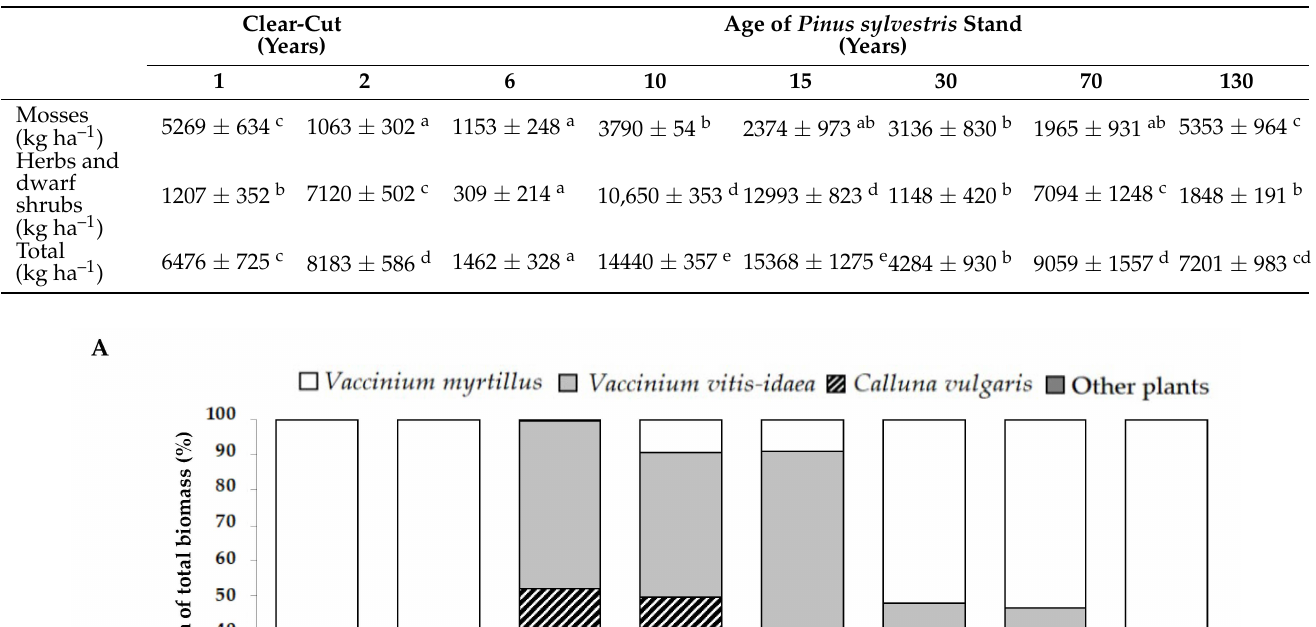
Table 6. Aboveground biomass (kg ha –1 ; mean ± SE) of the mosses and herbs and dwarf shrubs at different Pinus sylvestris sites, including 1–2-year-old clear-cuts and 6–130 years old stands. Different letters a, b, and c indicate significant differences among sites ( p < 0.05).